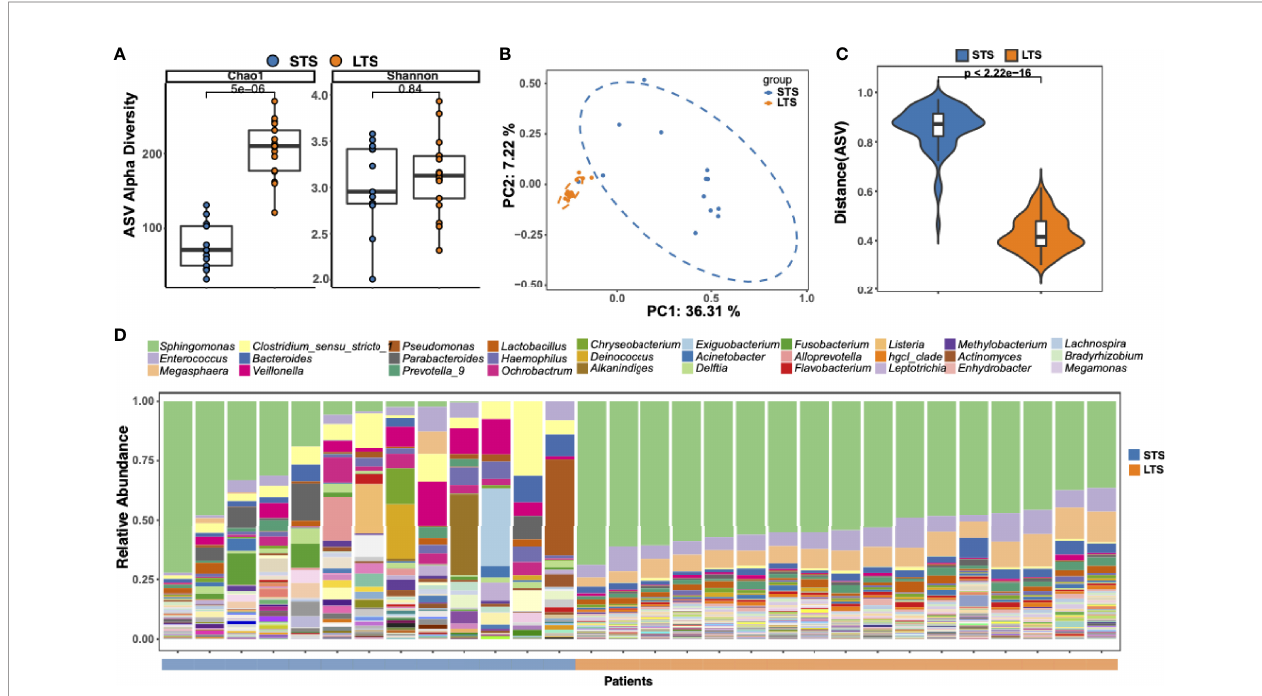
FIGURE 1 | Tumor microbial community differs between long-term and short-term PDAC survivors. (A) Alpha diversity boxplot (Chao 1 and Shannon indices) in long-term and short-term survival patients. (B) Principal coordinate analysis of different samples using Bray-Curtis metric distances of beta diversity. Orange dot indicates LTS sample, and blue dot indicates STS sample. (C) Violin plots of the Bray-Curtis distance between samples from the same group across different patients. (D) Stack bar charts of genus-level bacterial composition for the LTS and STS patient samples. Relative abundances were calculated by summing up the reads of species that past all fi lters and belong to the same genus. The top 30 genera name are shown in the